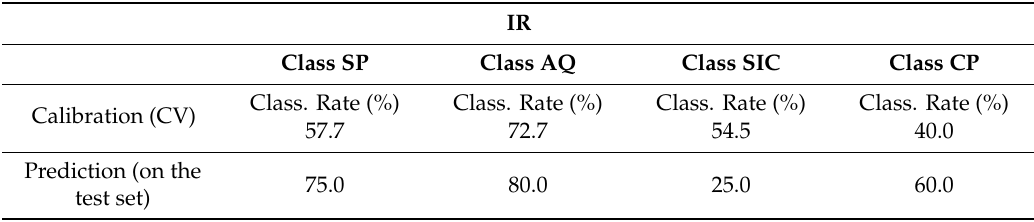
Table A1. PLS-DA analysis on IR data: Correct classification rates (%) for calibration (CV) and validation (test